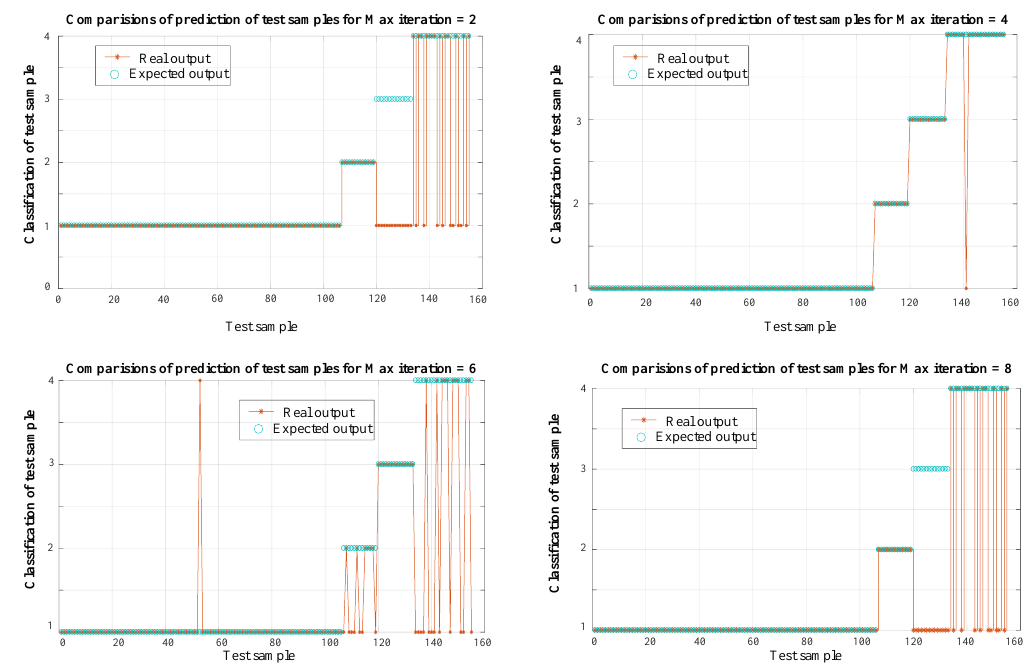
Figure 7. MDE-WOA-PNN training result classification and test set classification result.